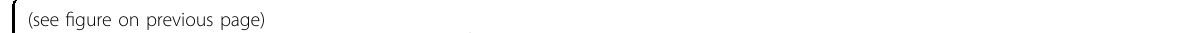
Fig. 6 Spermatogenic defects of the AMH-hACE2-N F/F mice after SARS-CoV-2 GFP/ Δ N infection. a Illustration and representative H&E images of testicular section of WT mice show properly arranged testicular structure, seminiferous tubules and different cell types including Sertoli cells and germ cells at various stages. b Immuno fl uorescence staining of SARS-CoV-2 GFP in AMH-hACE2-N F/F mouse testes. c Representative image of testis dissected from mock and SARS-CoV-2 GFP/ Δ N-infected AMH-hACE2-N F/F mouse. d Average weight of testis ( n = 5 – 10 for each group). Error bars represent mean ± SD. e The diameter of seminiferous tubules. f Sperm counts. The epididymis was dissected, sperms were rinsed out for counting the number per testicle ( n = 5 – 10 for each group). Error bars represent mean ± SD. * P < 0.05, ** P < 0.01 by t -test comparing to the controls. g Histopathological changes of testis from SARS-CoV-2 GFP/ Δ N -infected AMH-hACE2-N F/F mice and control mice. h Representative H&E images of epididymis of mock and SARS-CoV-2 GFP/ Δ N infected AMH-hACE2-N F/F